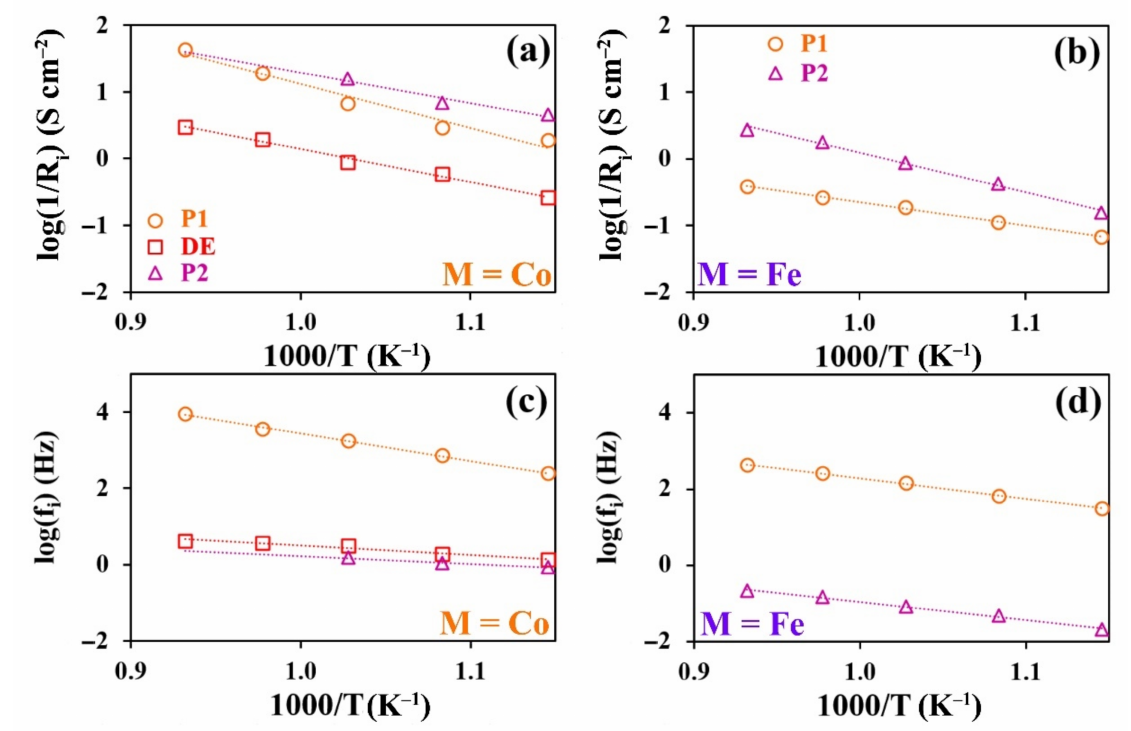
Figure 9. Partial values of the polarization resistances ( a , b ) and frequencies ( c , d ), determined by fitting of impedance spectra, corresponding to the electrode processes in symmetrical cells for PNC|BCZY|PNC ( a , c ) and PNF|BCZY|PNF ( b , d